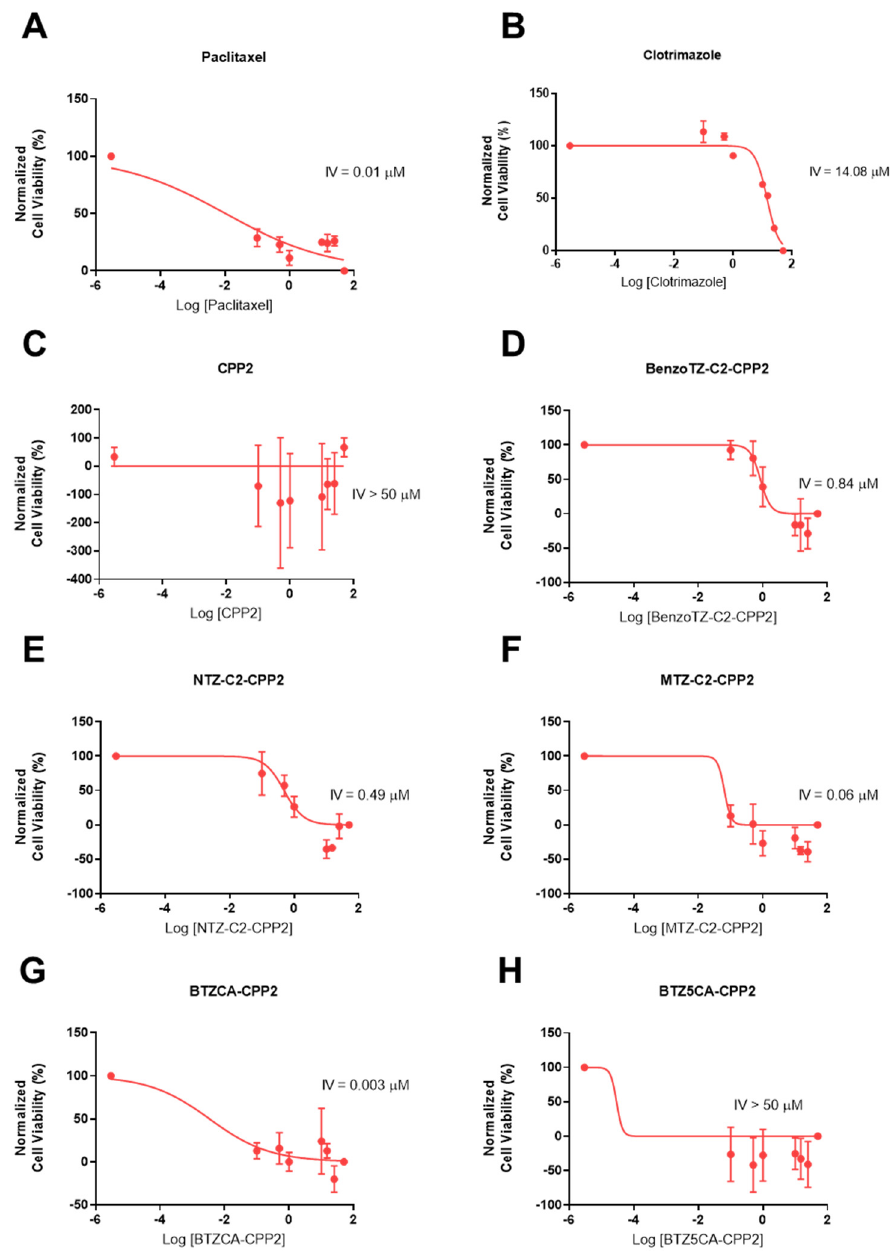
Figure 4. Concentration–response curves of PTX ( A ), CLZ ( B ), CPP2 ( C ), BenzoTZ-C2-CPP2 ( D ), NTZ-C2-CPP2 ( E ), MTZ-C2-CPP2 ( F ), BTZCA-CPP2 ( G ) and BTZ5CA-CPP2 ( H ) on PC-3 cells based on the results obtained by MTT assay. The results represent the mean ± SEM of three independent experiments performed in triplicate.